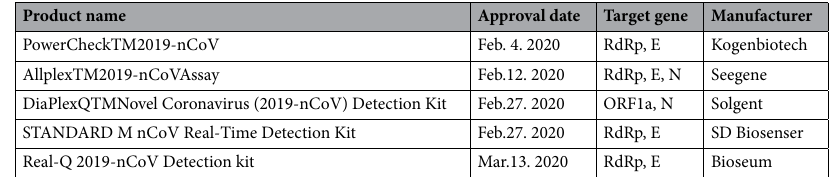
Table 2. SARS-CoV-2 (COVID-19) nucleic acid detection kits with emergency use approval (EUA) in the Republic of